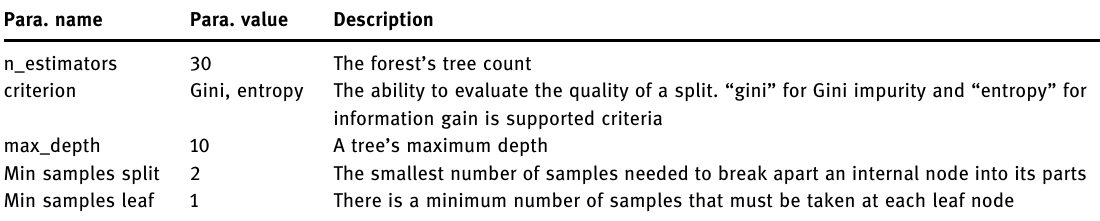
Table 3: Parameters in RF algorithm Para.